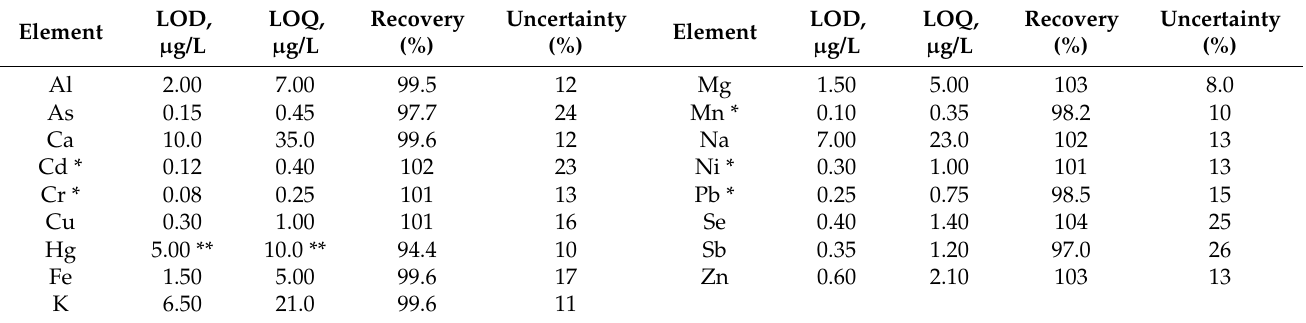
Table 1. Detection and quantification limits, recovery and uncertainty percentages for the applied methods regarding